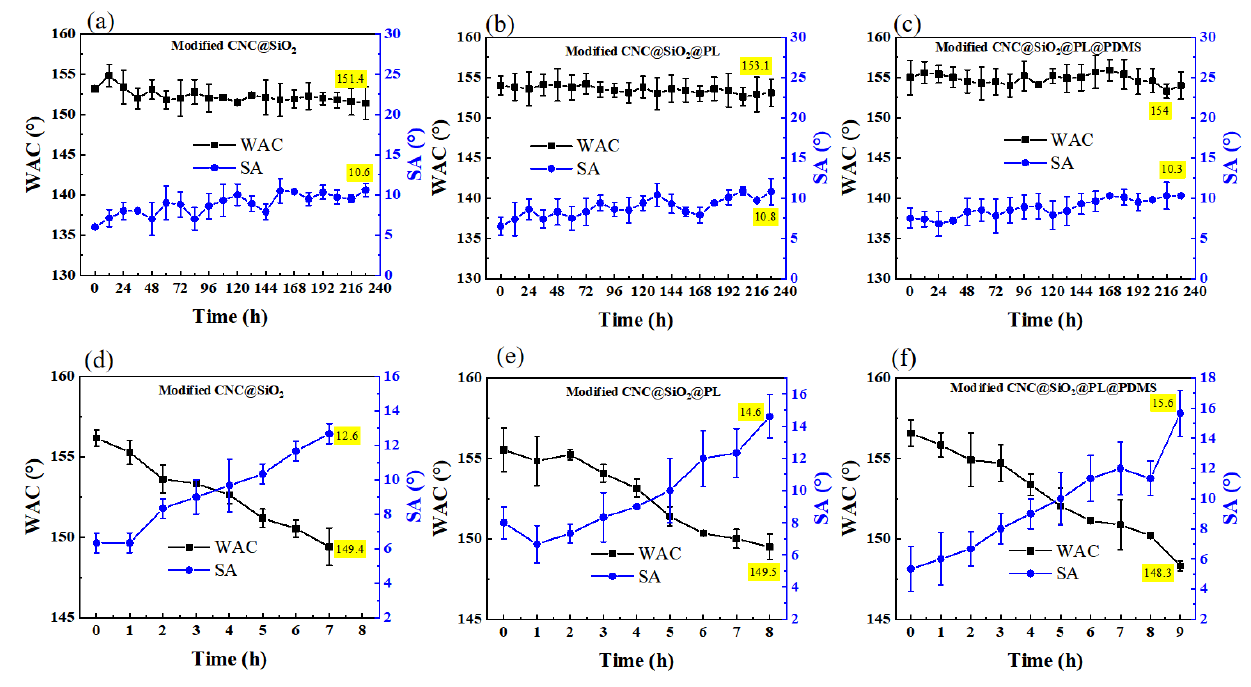
Figure 6. Change curves of WCAs and SAs on the modified CNC@SiO 2 , CNC@SiO 2 @PL, CNC@SiO 2 @PL@PDMS coatings with time of exposure to UV radiation of ( a – c )15 W or ( d – f ) 1000 W. Table 3. Comparison of different superhydrophobic coatings for UV resistance. Table 3. Comparison of different superhydrophobic coatings for UV